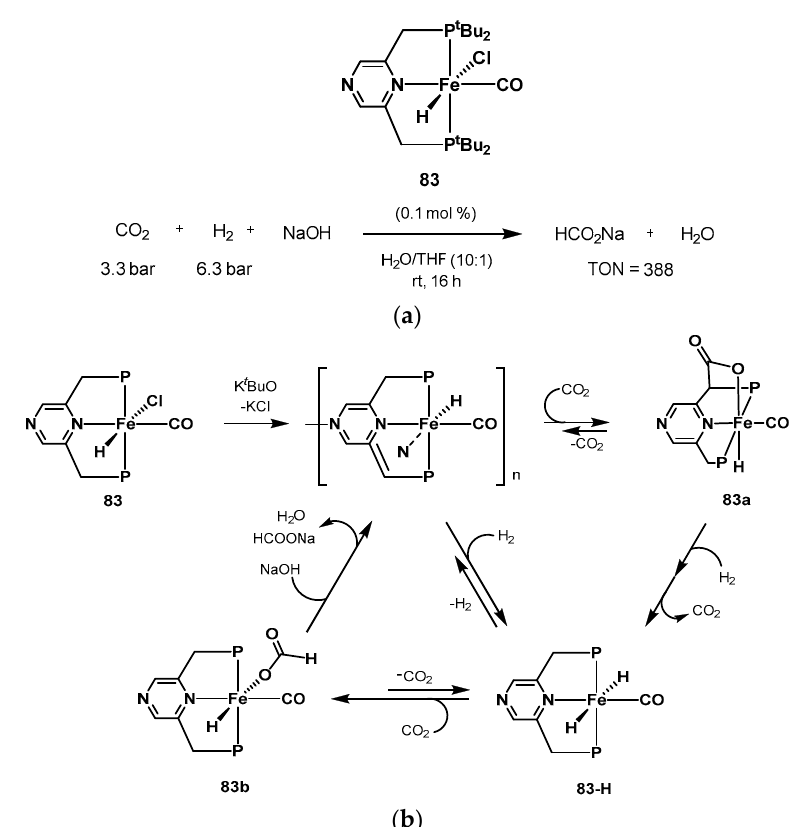
Scheme 68. ( a ) Hydrogenation of CO 2 catalyzed by 83 and ( b ) the proposed mechanism for hydrogenation of CO 2 reported by Milstein